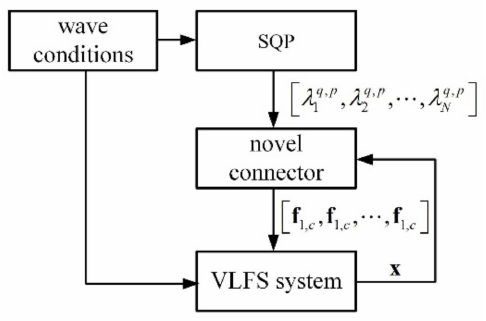
Figure 4. The flow chart of the control